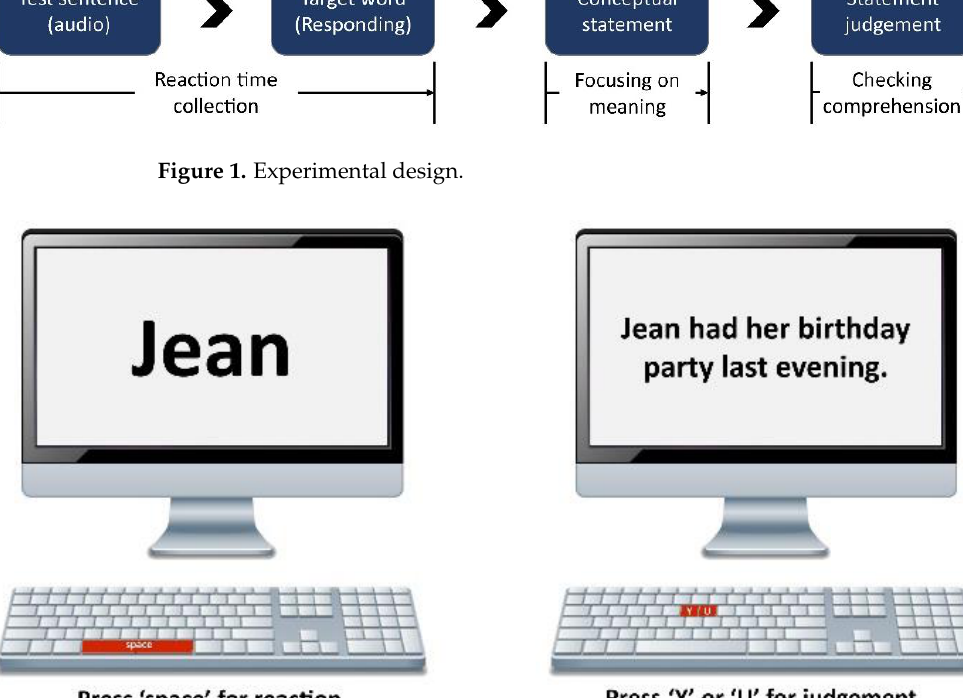
Figure 2. Illustration for the experimental operation.